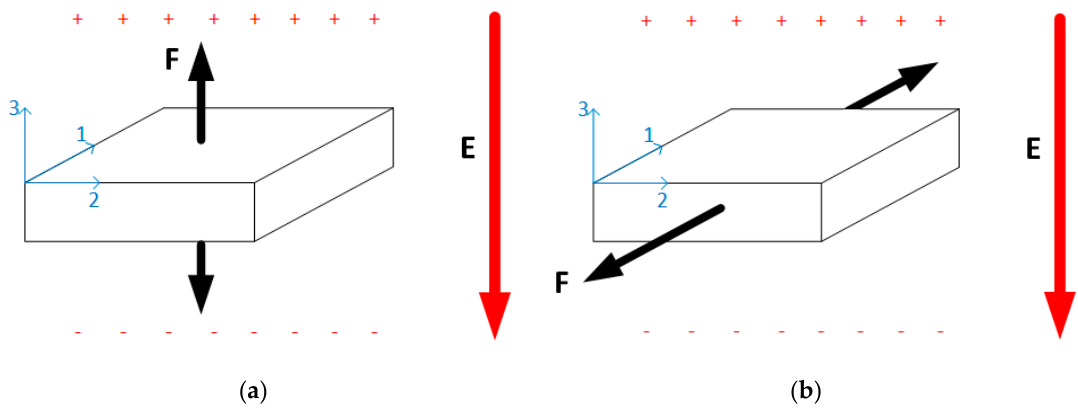
Figure 9. Working mode: ( a ) d 33 mode (transverse mode) ( b ) d 31 mode (longitudinal mode).